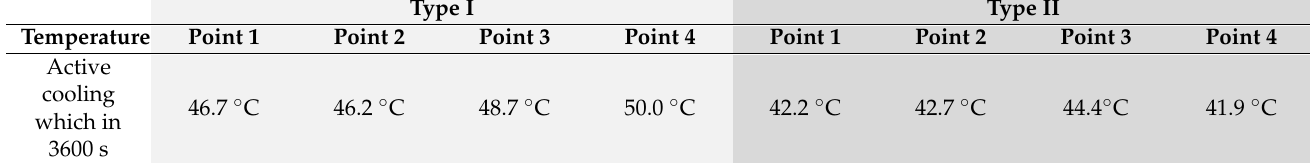
Figure 24. Temperature responses in Type I upper-plate point. Table 6. Upper-plate experiment Figure 25. Temperature responses in Type II Upper-plate point.